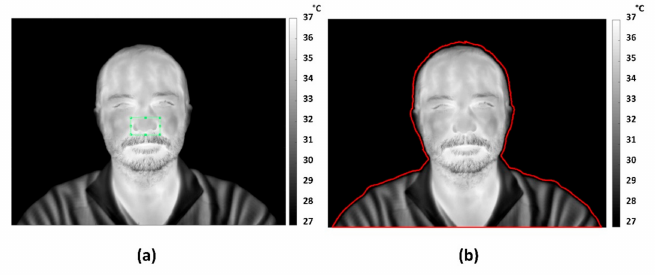
Figure 1. ( a ) Rectangular master ROI (mROI) initialized by the user on the first frame of the thermal video; ( b ) segmentation of thermal image through Otsu